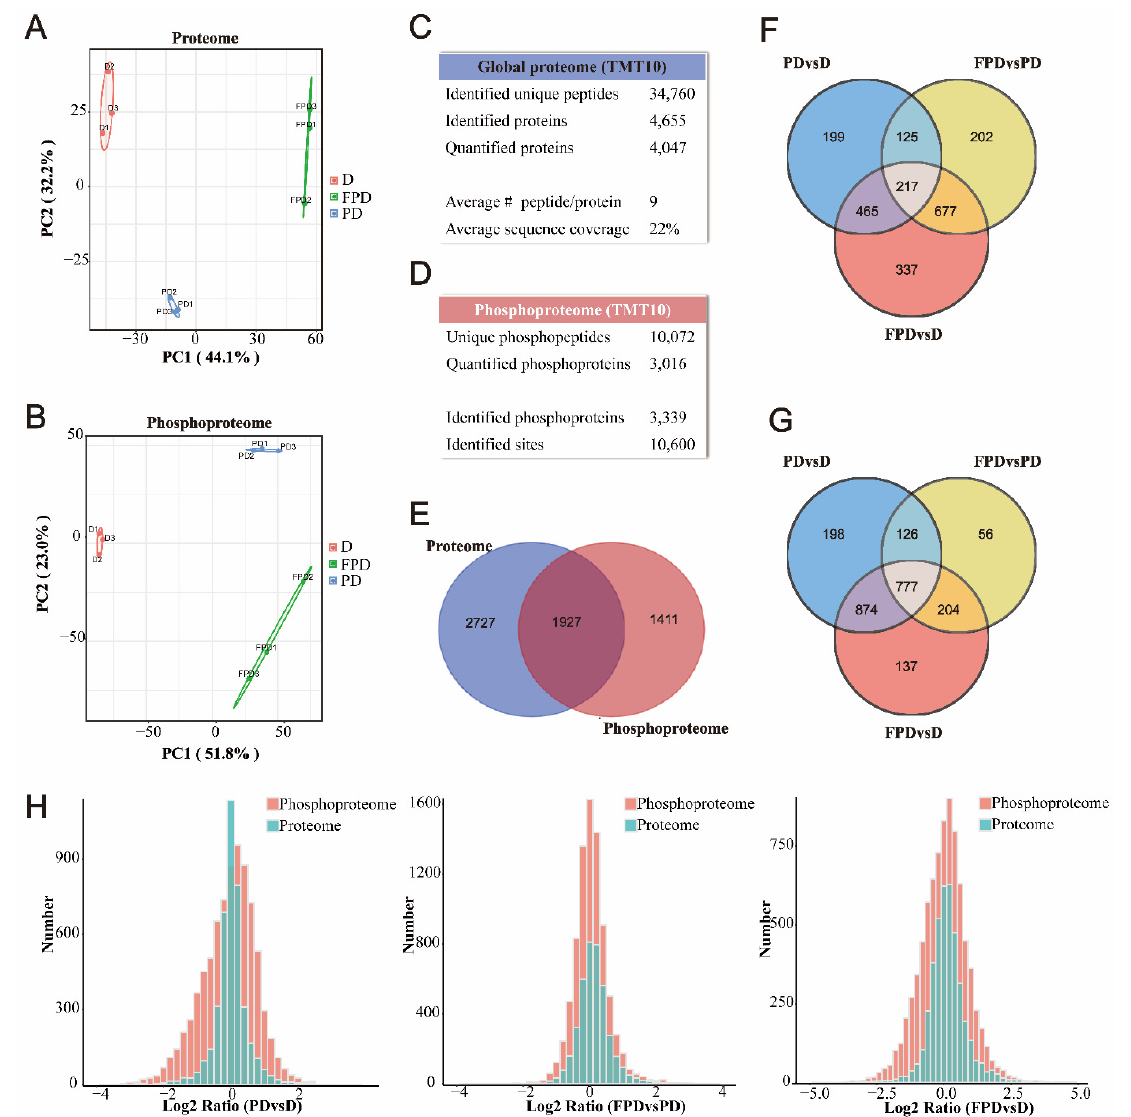
Figure 2. Overview of the proteomes and phosphoproteomes of the three diapause stages in Bombus terrestris . ( A , B ) Principal component analysis (PCA) of quantified proteins and quantified phospho- peptides from D, PD, and FPD. ( C , D ) The summary information of proteome/phosphoproteome. ( E ) Venn diagram of proteins and phosphoproteins identified in proteome and phosphoproteome experiments, respectively. ( F , G ) Venn diagram illustrating differentially expressed proteins or phosphoproteins in each group comparison (PD vs. D, FPD vs. PD, and FPD vs. D). ( H ) Distribution histograms of log fold-change comparing proteomes (green) and phosphoproteomes (red) identified in three comparable groups.